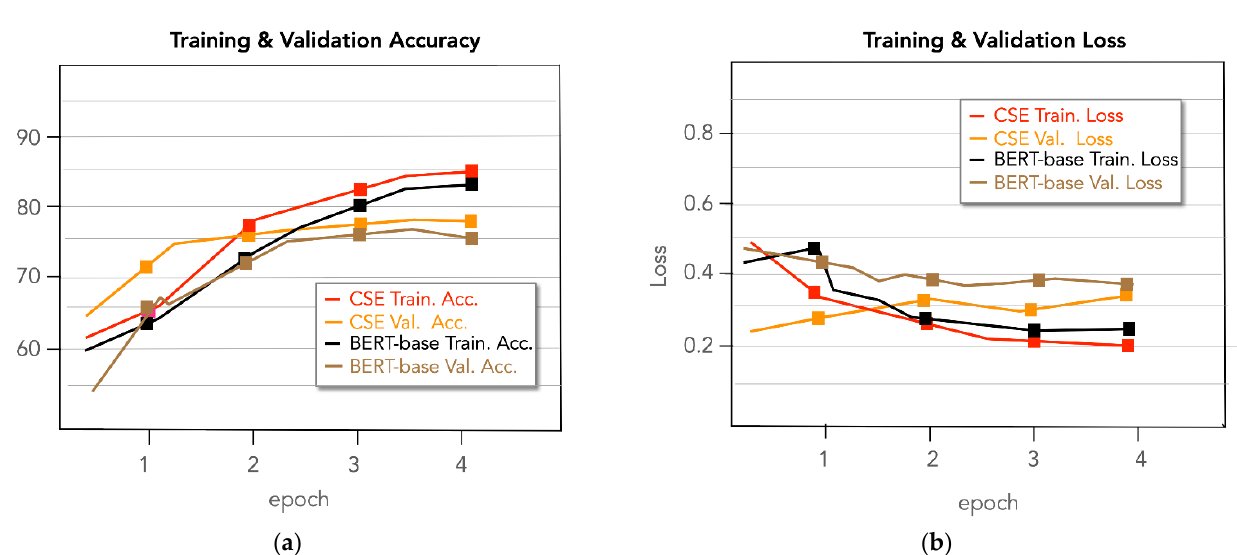
Figure 6. Comparison of accuracy on the validation set as a function of corpus percentage. Furthermore, we investigated the impact of the number of layers transferred during fine-tuning from the unsupervised pre-training to the persistence recognition task. Figure 7, depicts the performance of the CSE-PersistenceBERT model as a function of the trans- ferred layers. As an observation, we confirmed that each layer of the pre-trained BERT model contains valuable information for the persistence recognition task. Thus, CSE-Per- sistenceBERT improved its performance in the persistence recognition task by transferring its “knowledge”.